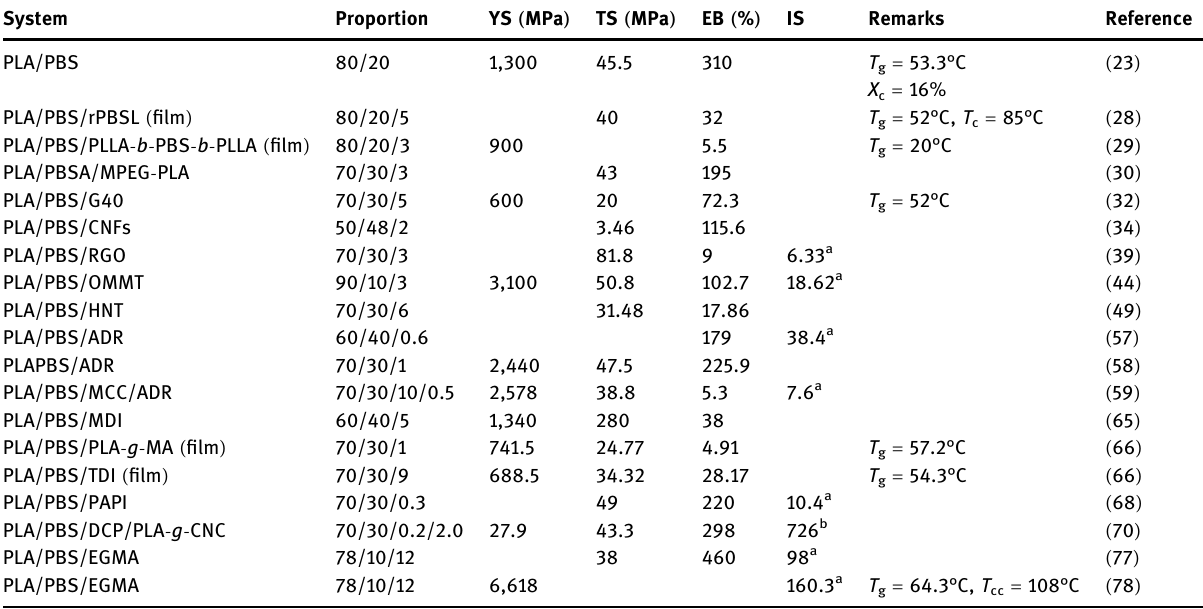
Table 1: Mechanical properties of PLA/PBS composite materials System